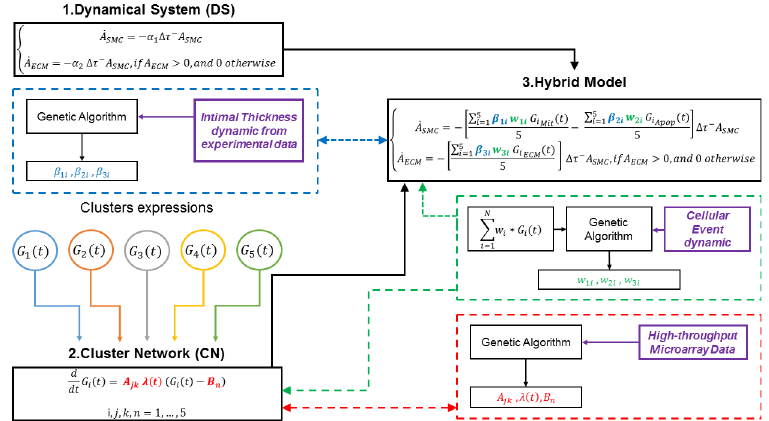
Fig 2. Hybrid model development step-by-step diagram. Significantclusters of expression(G i (t)) are organized in Cluster Network (CN) through an Ordinary Differential Equations(ODE) system, which unknowns(highlightedin bold red) are retrieved fitting the ODE system on experimental data from gene microprobes (dashedred line box). The CN is plugged into a Dynamical System (DS) that simulate the long- term vein graft healing,to create a hybrid model, characterized by 2 kinds of unknowns: in bold green the weights of each cluster on a specific cellularevent, that are retrieved on the base of experimental data (dashedgreen line box); in bold blue the scalingfactors that adjust the unite of measurement of each cluster expressioninto the hybrid model, also retrieved on the base of experimental data (dashedblue line box). In general,a large use of heterogenicexperimental data (highlightedin bold purple)has been made at various levels through the development of the model for validation and calibrationpurposes.